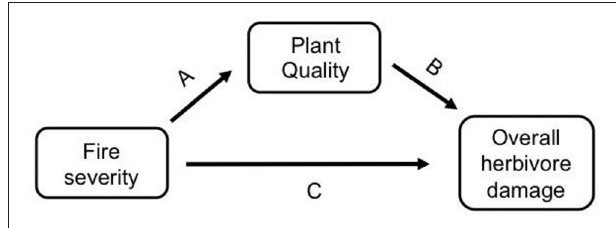
FIGURE 1 | A conceptual model of how herbivore damage may be affected by fire severity either indirectly via changes in host plant quality (i.e., fire severity directly affects host plant quality [path A] , which then affects herbivore damage [path B] ), or directly via changes to the habitat [path C] .